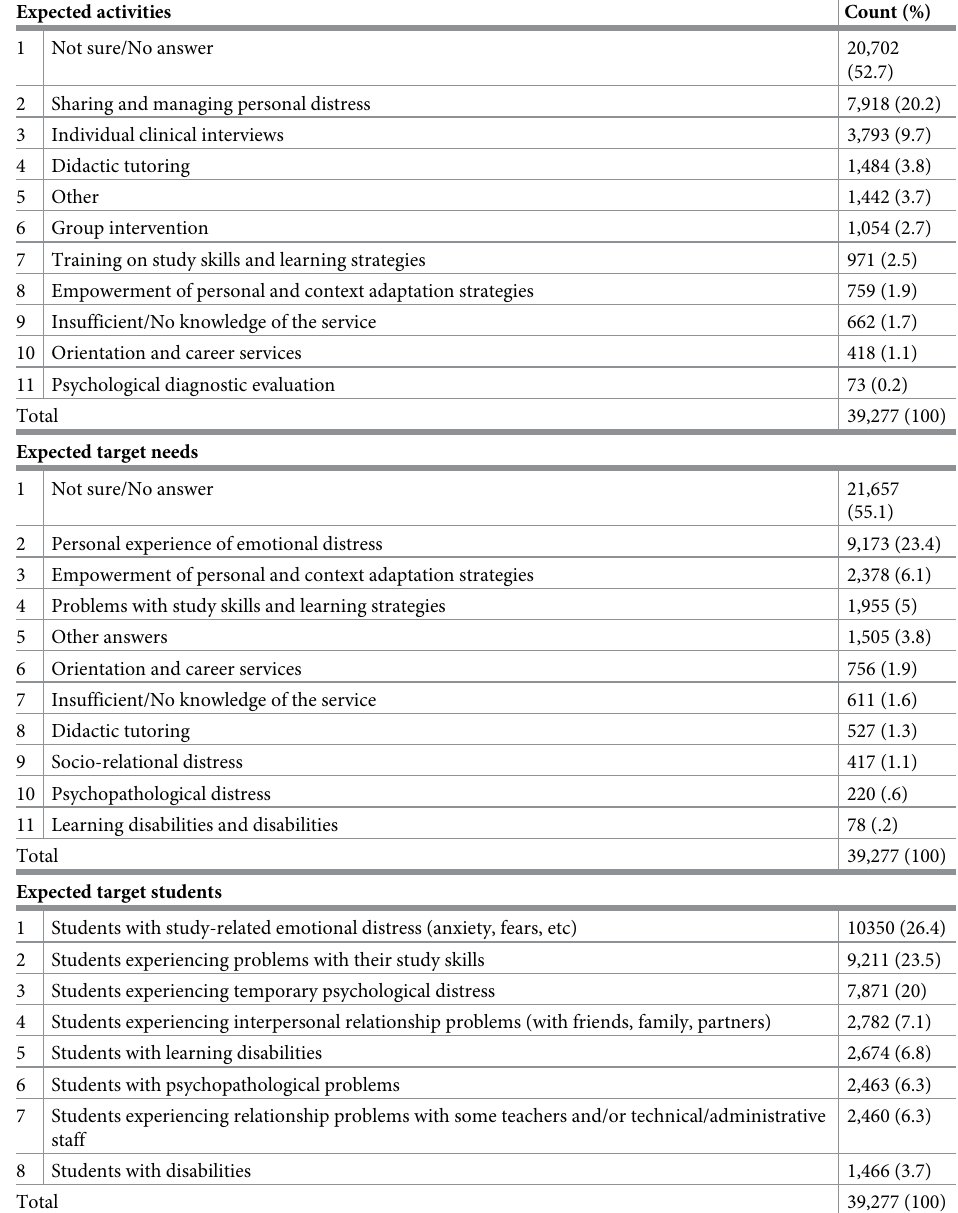
Table 2. Active variables with their respective categories. This table collects answers to the third part of the survey and reports for each variable the number of answers in each category with the corresponding percentages (within